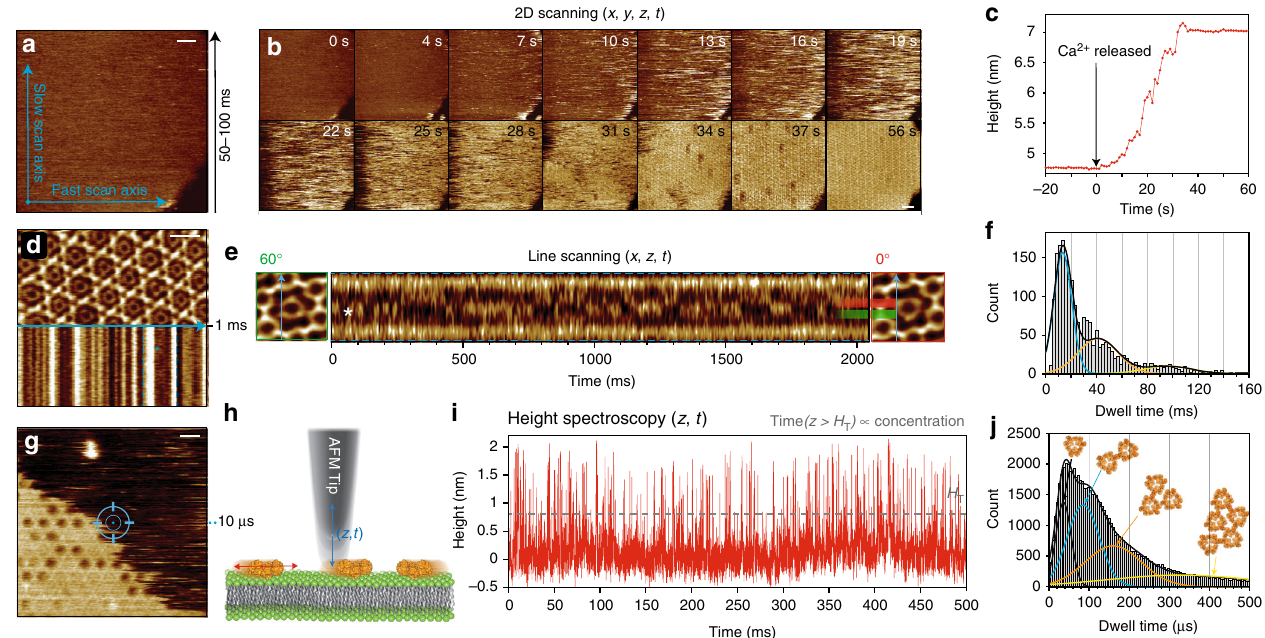
Fig. 1 Increasing the temporal resolution of HS-AFM by reducing the dimensionality of data acquisition. a HS-AFM image of a DOPC/DOPS (8:2) membrane in the presence of annexin-V and NP-EGTA-caged Ca 2 + . Blue arrows illustrate the slow- (vertical) and the fast-scan axis (horizontal). Images can be captured at up to 10 – 20 frames s − 1 . b HS-AFM movie frames of A5 membrane-binding, self-assembly and formation of p 6 2D-crystals upon UV- illumination induced Ca 2 + -release. c Average height/time trace of the membrane area in b . d Averaged HS-AFM image of an A5 p 6-lattice overlaid with the subsequent line scanning kymograph, obtained by scanning repeatedly the central x -direction line as illustrated by the blue arrow with a maximum rate of 1000 – 2000 lines s − 1 . e Line scanning kymograph across one protomer of the non- p 6 trimer, marked by * in d and e at a rate of 417 lines s − 1 (2.4 ms per line). f Histogram of state dwell-times of the molecule in e . g HS-AFM image of an A5 p 6-lattice partially covering a DOPC/DOPS (8:2) SLB surface